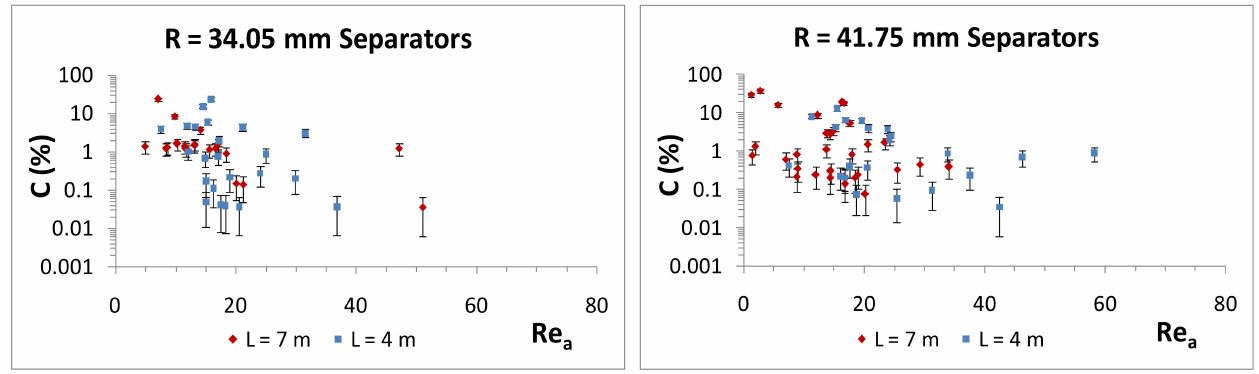
Figure 9. Relationship between the apparent Reynolds number Re a and the water concentration C (%) for the separators tested with different helix radiuses R (34.05 mm and 41.75 mm) and tube lengths L (4 and 7